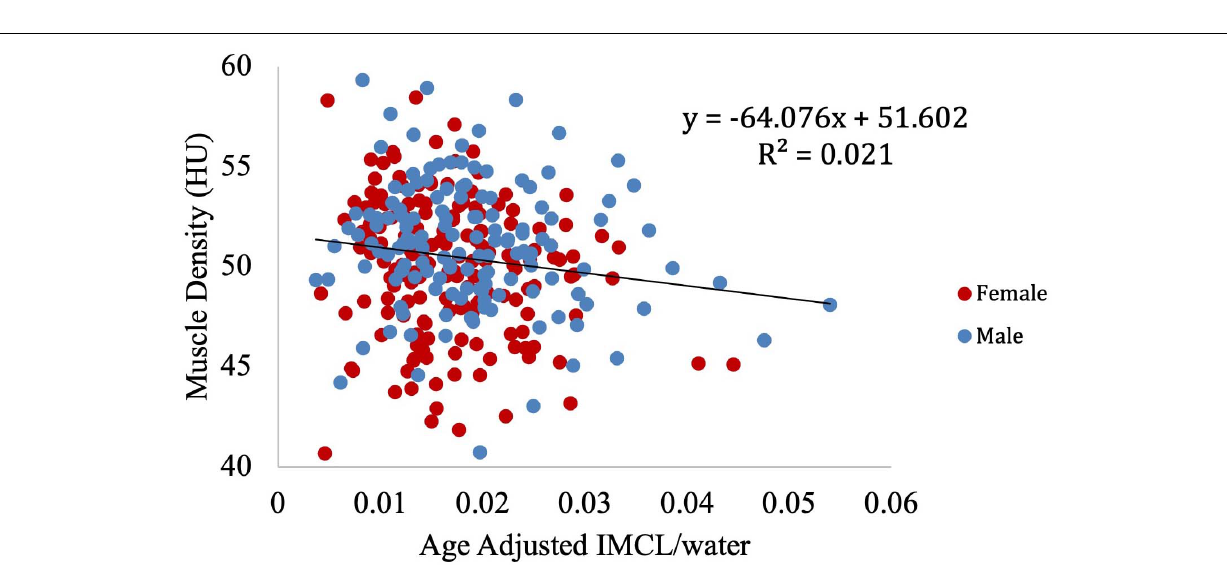
FIGURE 11 | Correlation between age-adjusted IMCL/water ratio obtained from MR spectroscopy and muscle density obtained from CT. As shown, decreased density was associated with increased age adjusted IMCL/water ( p < 0.01). The age adjusted IMCL/water values were calculated using a LOESS